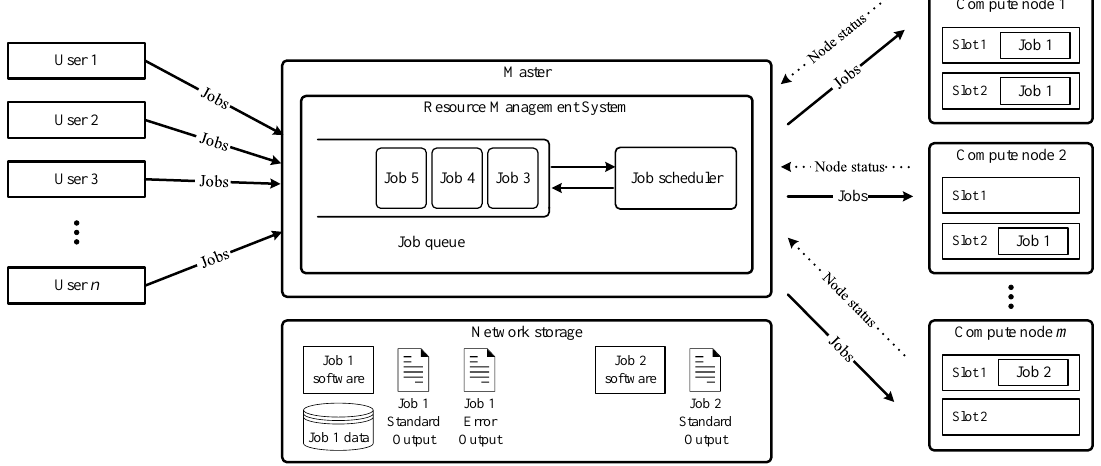
Figure 1. Resource Management System (RMS)